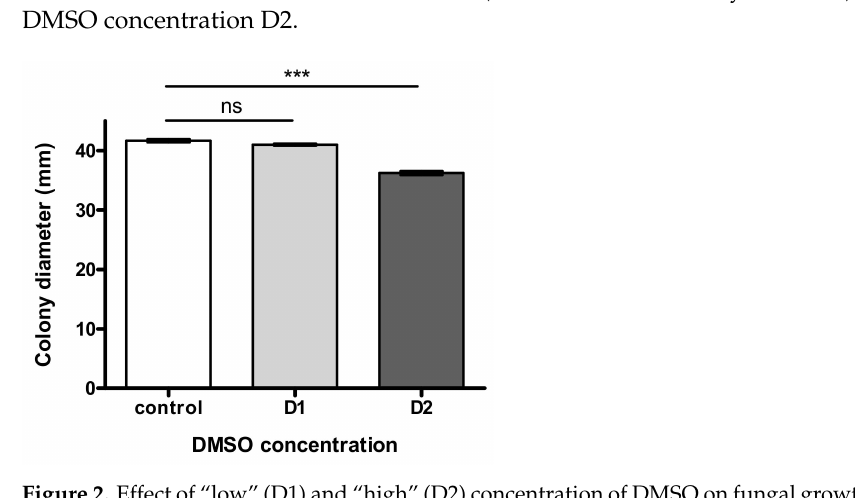
Figure 2. Effect of “low” (D1) and “high” (D2) concentration of DMSO on fungal growth of Aspergillus flavus NRRL 62477 after 4 days of incubation at 27 ◦ C. ns = no significant difference; *** p <